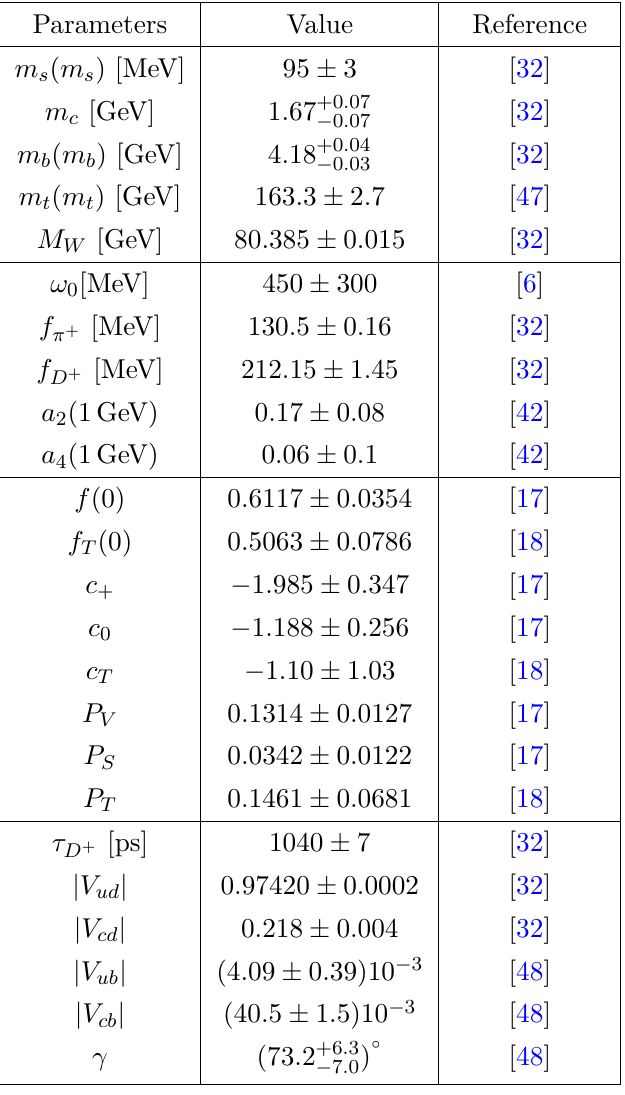
Table 3 . Summary of the numerical input used in the study of D + → π + ‘ + ‘ − .